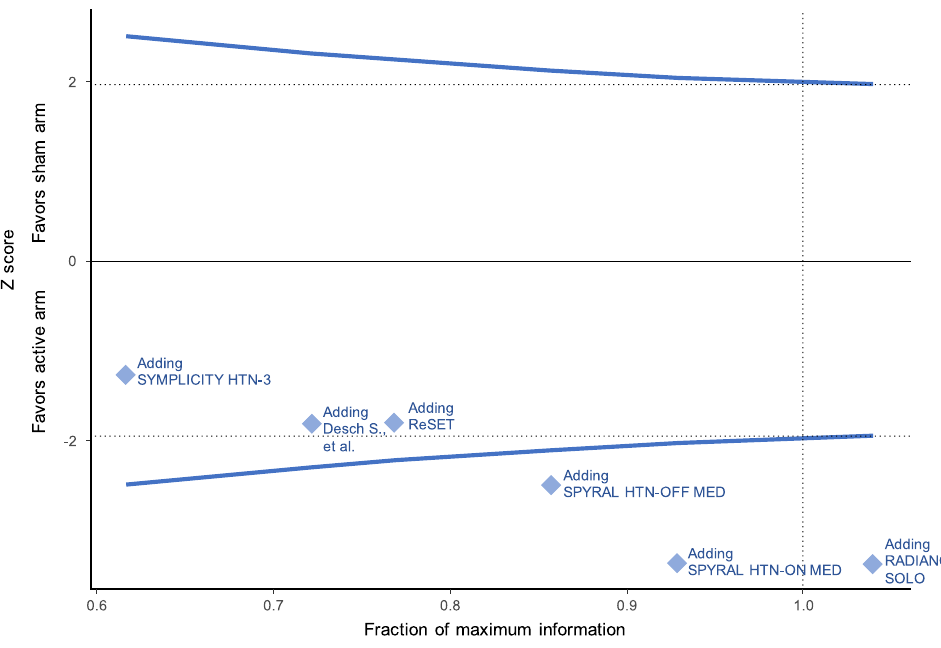
Figure 3. Hypothetical prospectively planned sequential fixed effect meta-analysis framework (type I error=5%,